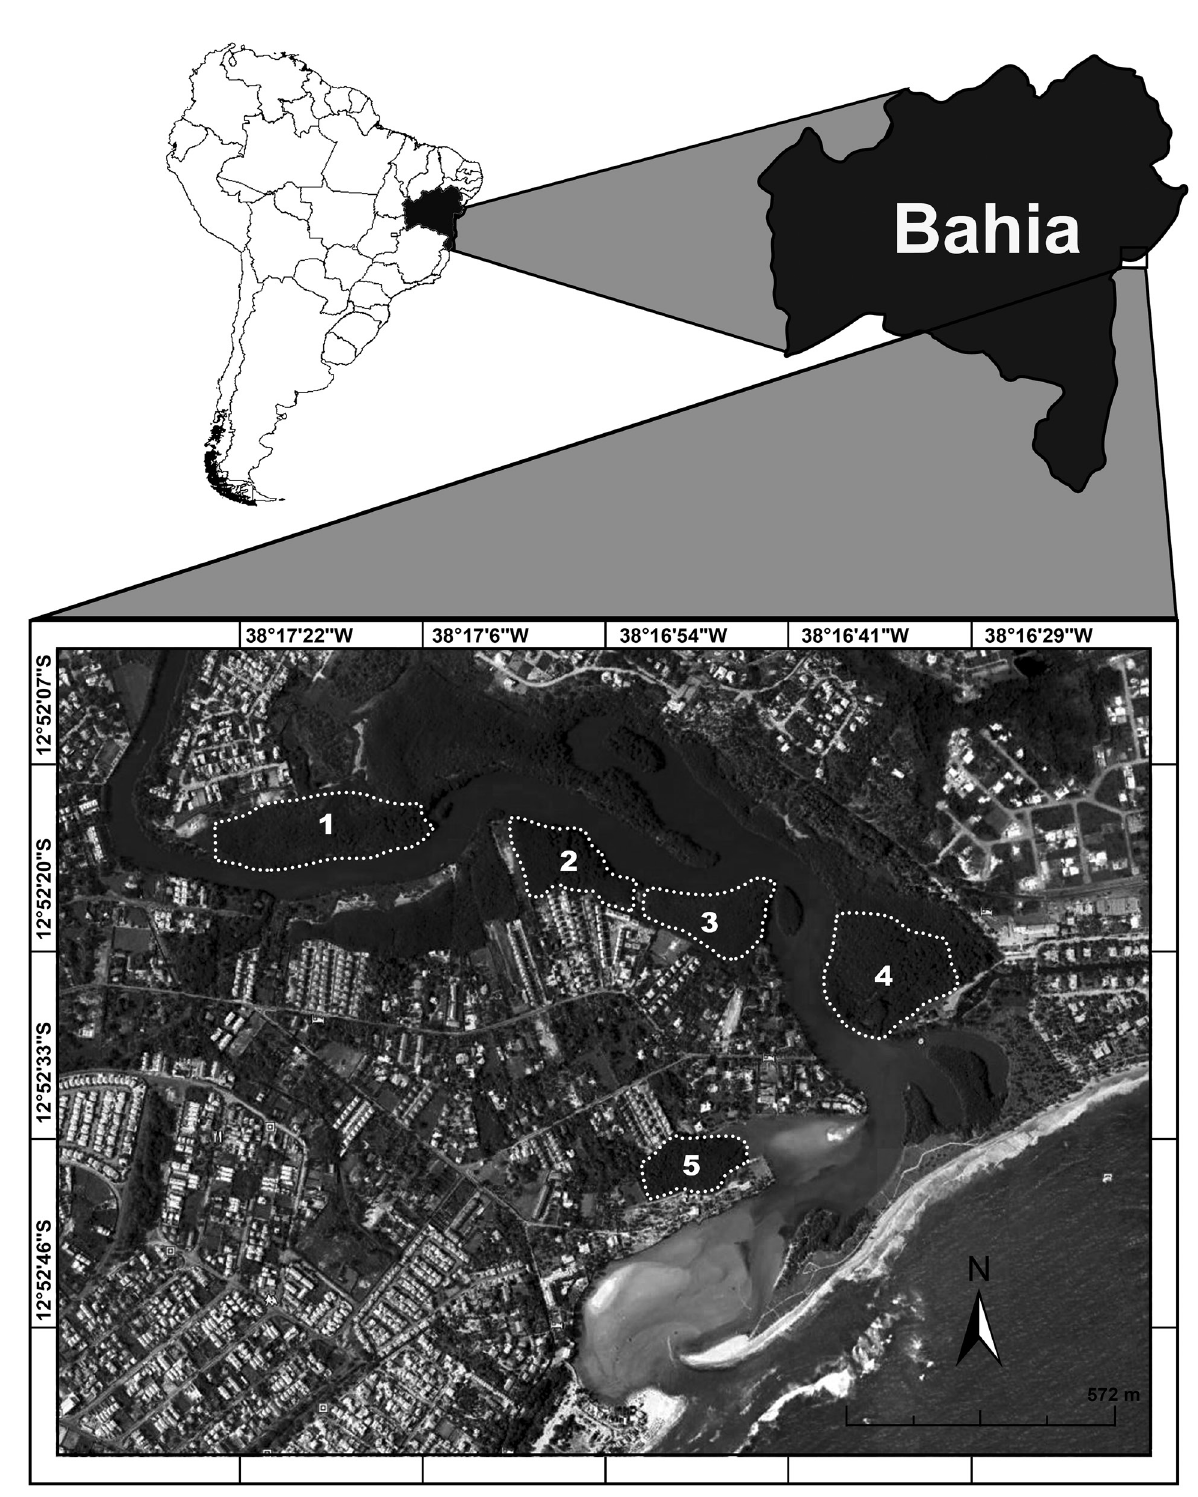
Figure 1. Estuary of the Joanes River, Lauro de Freitas municipality (Bahia State, Brazil), indicating the five mangrove areas where ‘uçá’- crabs ( Ucides cordatus ) was captured monthly from September 2011 to August 2012. This satellite photo was modified based on Image © 2013 Digital Globe and Image © 2013 Terra Metrics, available at Google Earth TM